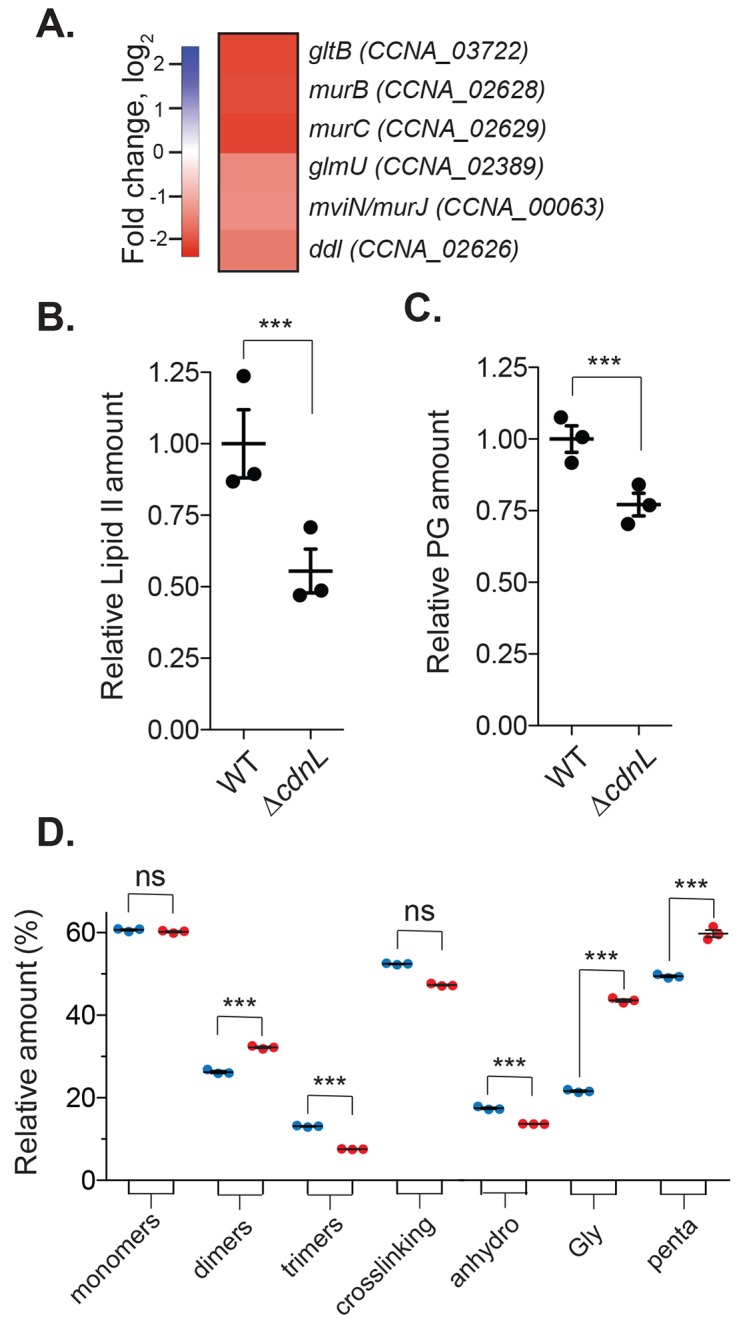
CdnL impacts cell wall precursor synthesis and cell wall metabolism.A. Heatmap showing changes of the indicated transcripts involved in lipid II synthesis and cell wall remodeling in WT (EG865) and ΔcdnL (EG1415) using RNA-seq. B-C. Relative amount of lipid II and peptidoglycan in WT (EG865) and ΔcdnL (EG1447) cells. D. Indicated muropeptide species from WT (EG865) and ΔcdnL (EG1447). X-axis shown in D are (1–6 anhydro) N-acetyl muramic acid (anhydro), Gly containing muropeptides (Gly), and pentapeptides (penta). Values in B-D are from three independent cultures and mean and SEM are indicated. Statistical analysis performed using unpaired t test. *** = P < 0.001, ** = P < 0.01, * = P < 0.05.